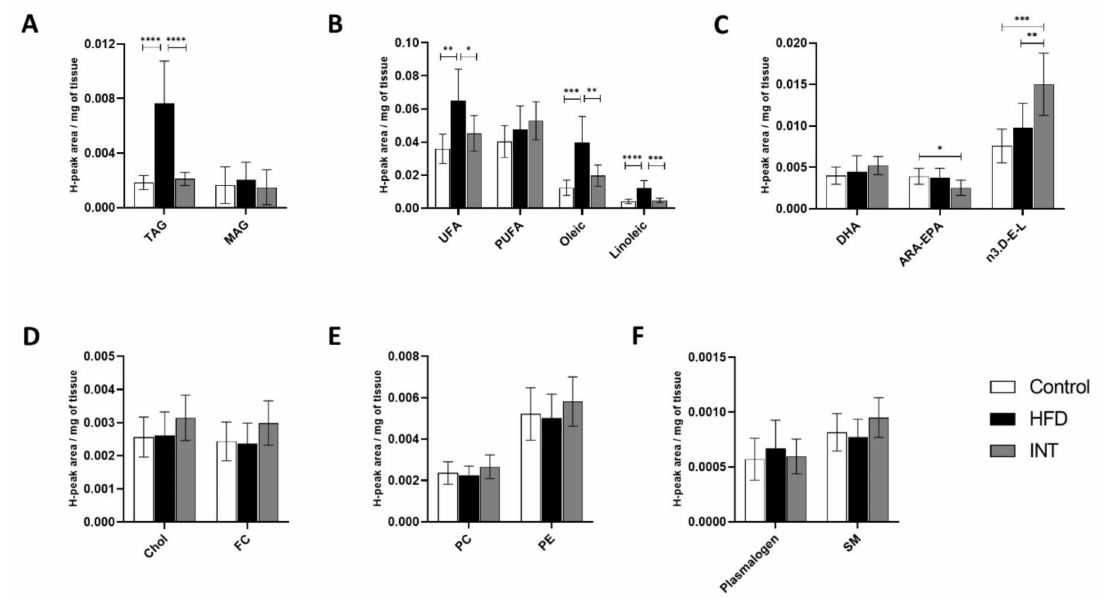
Figure 4. Alterations in metabolite lipid profile in gastrocnemius. Representation of the changes induced by HFD and the intervention following the HFD on the presence of ( A ) glycerolipids, ( B , C ) fatty acids, ( D ) sterol lipids and ( E , F ) phospholipids and sphingolipids. Ctrl n = 8, HFD n = 7, INT n = 7. Y-axis values indicate H-peak area/mg of tissue. Data represented as mean ± SEM, one-way ANOVA and post-hoc Tukey’s tests, * p < 0.05, ** p < 0.01, *** p < 0.001, and **** p <